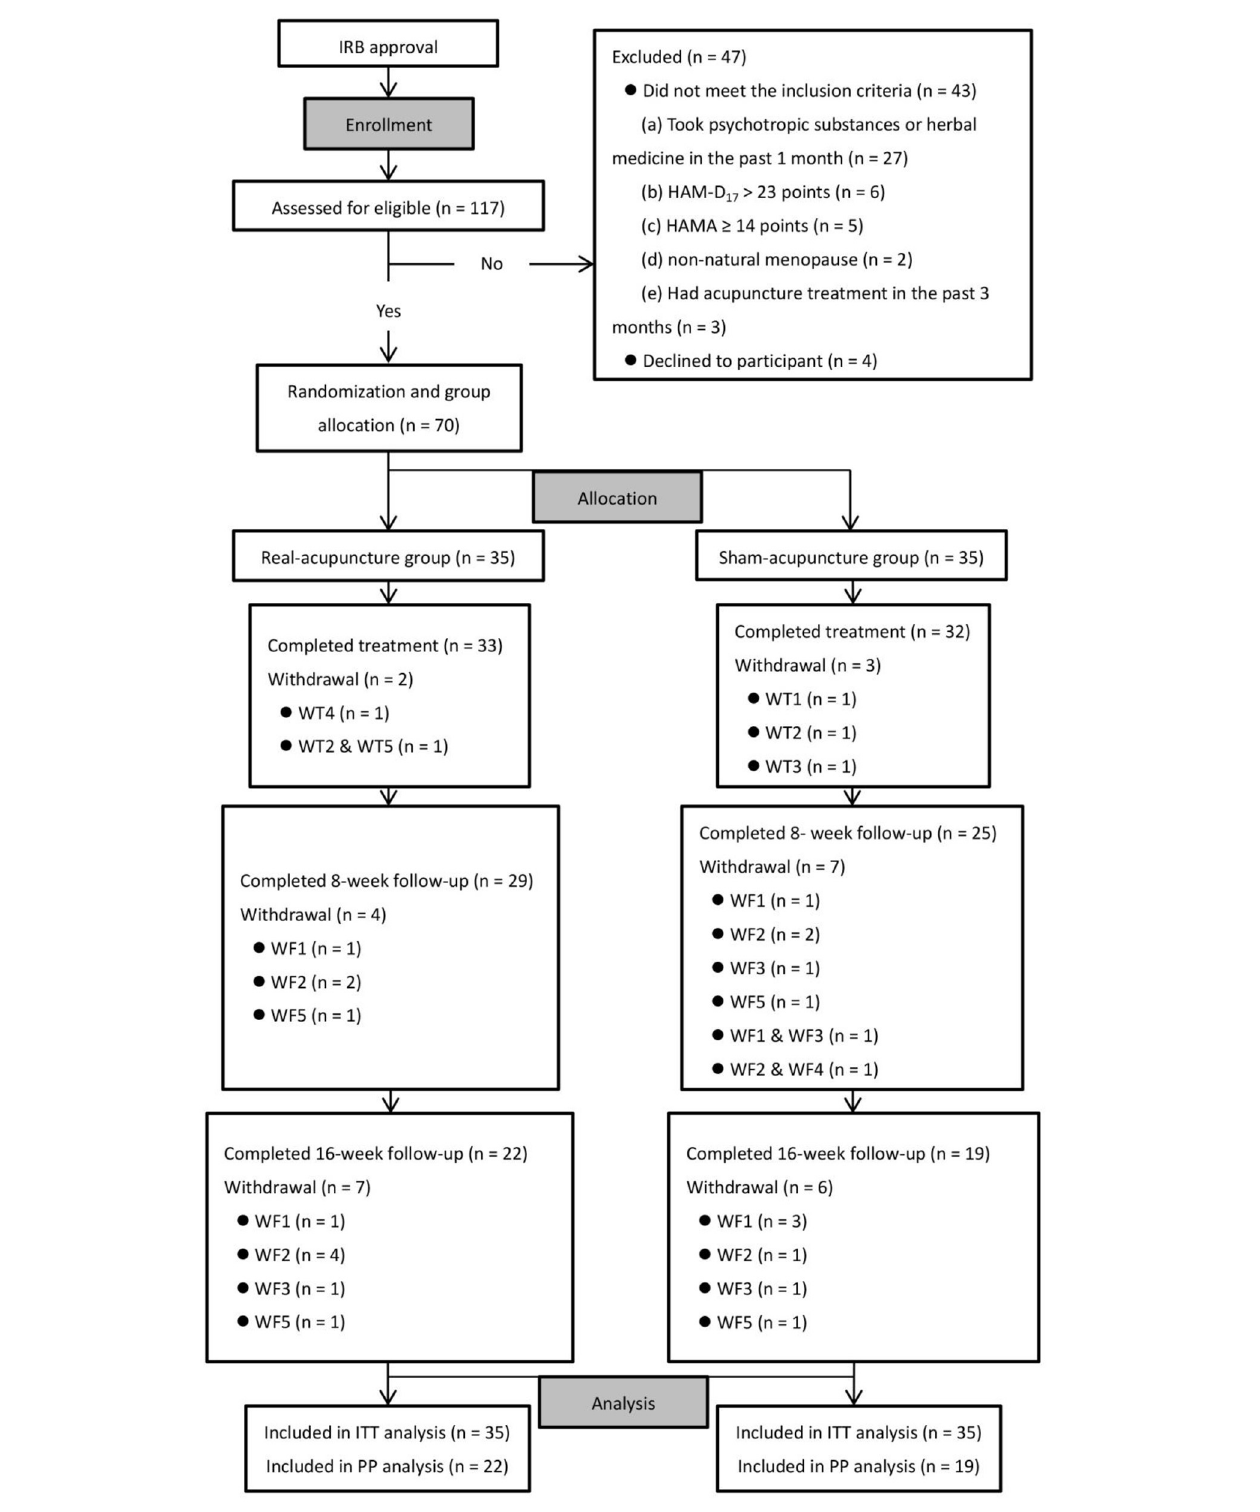
FIGURE1 Trial flow diagram. Reasons for WT (WT1, unable to arrange time to receive treatment due to changes in work schedule; WT2, reluctant to receive further treatment because she feels it does not work as expected; WT3, consider that the treatment has achieved the desired effect and no further treatment is required; WT4, unable to continue this trial because she is under treatment for other serious medical conditions; WT5, reluctant to receive further treatment as the COVID-19 outbreak has become severe and she is worried that coming to the hospital would increase her risk of contracting COVID-19); reasons for WF [WF1, reluctant to receive follow-up and assessment as she feels the procedures are time-consuming and very cumbersome (not associated with the COVID-19 outbreak); WF2, reluctant to receive follow-up and assessment as she feels the procedures are time-consuming and very cumbersome (associated with the COVID-19 outbreak); WF3, reluctant to receive further follow-up because she feels the treatment does not work as expected; WF4, consider that the treatment has achieved the desired effect and no further follow-up is required; WF5, lost contact without being informed the specific reasons]. WT, withdrawal at treatment phase; WF, withdrawal at follow-up phase; ITT, Intention-To-Treat analysis; PP, Per-Protocol